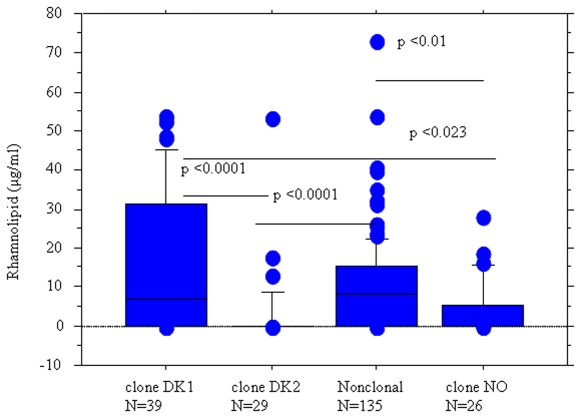
Distribution of rhamnolipid production in isolates belonging to different clones.Box and whisker plots represent the median (thick line inside the box), 10, 25, 75 and 90 centiles of the in vitro rhamnolipid production (µg/ml) of P. aeruginosa isolates belonging to different clones included in the study. The clones DK1 and DK2 are the two dominating clones in Denmark. Clone NO is a dominating clone in Norway and the non-clonal isolates have no clonal relationship. Mann-Whitney test was used to investigate the significance of the difference between the groups.